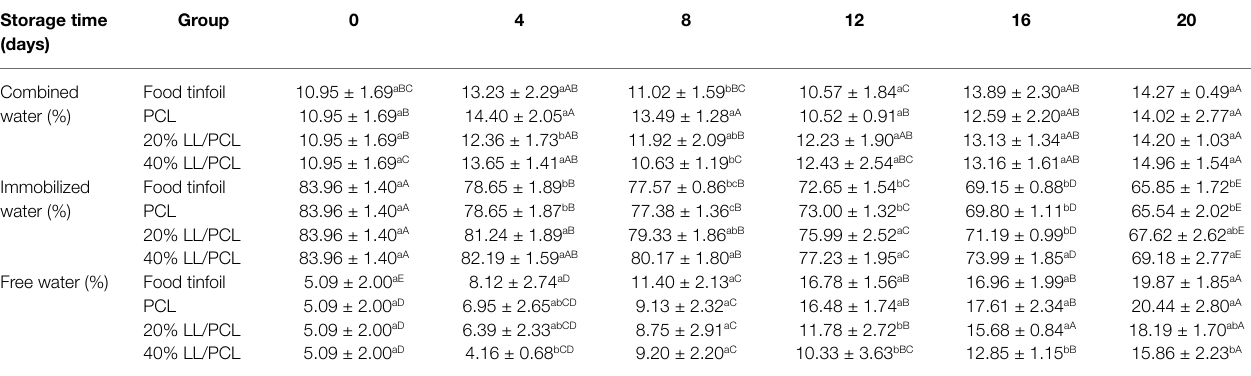
TABLE 2 | Change in water distribution of salmon during